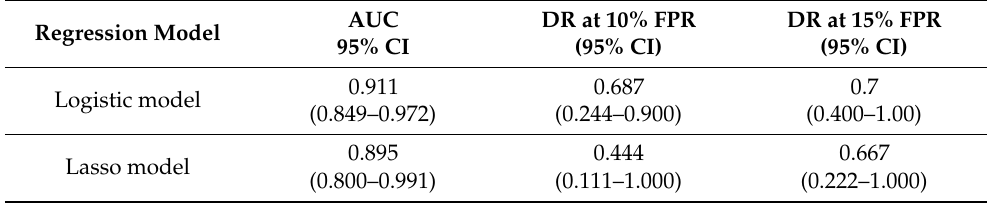
Table 5. Performance of 25-OH vitamin D for the prediction of severe